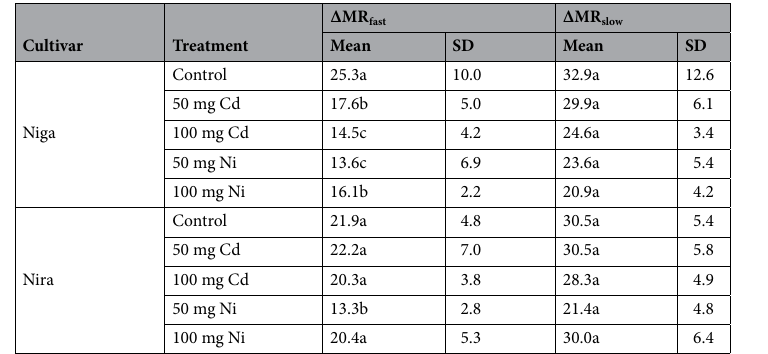
Table 4. Relative rates of P 700 oxidation (ΔMR fast ) and P 700+ re-reduction (ΔMR slow ) ± S.D. [relative units] calculated from the MR 820 signal of two perennial ryegrass turf cultivars (‘Niga’ and ‘Nira’) under different Ni and Cd treatment (0; 50 and 100 mg × 100 g −1 of substrate). Means within one cultivar marked by different letters represent significant differences ( p < 0.05, n =